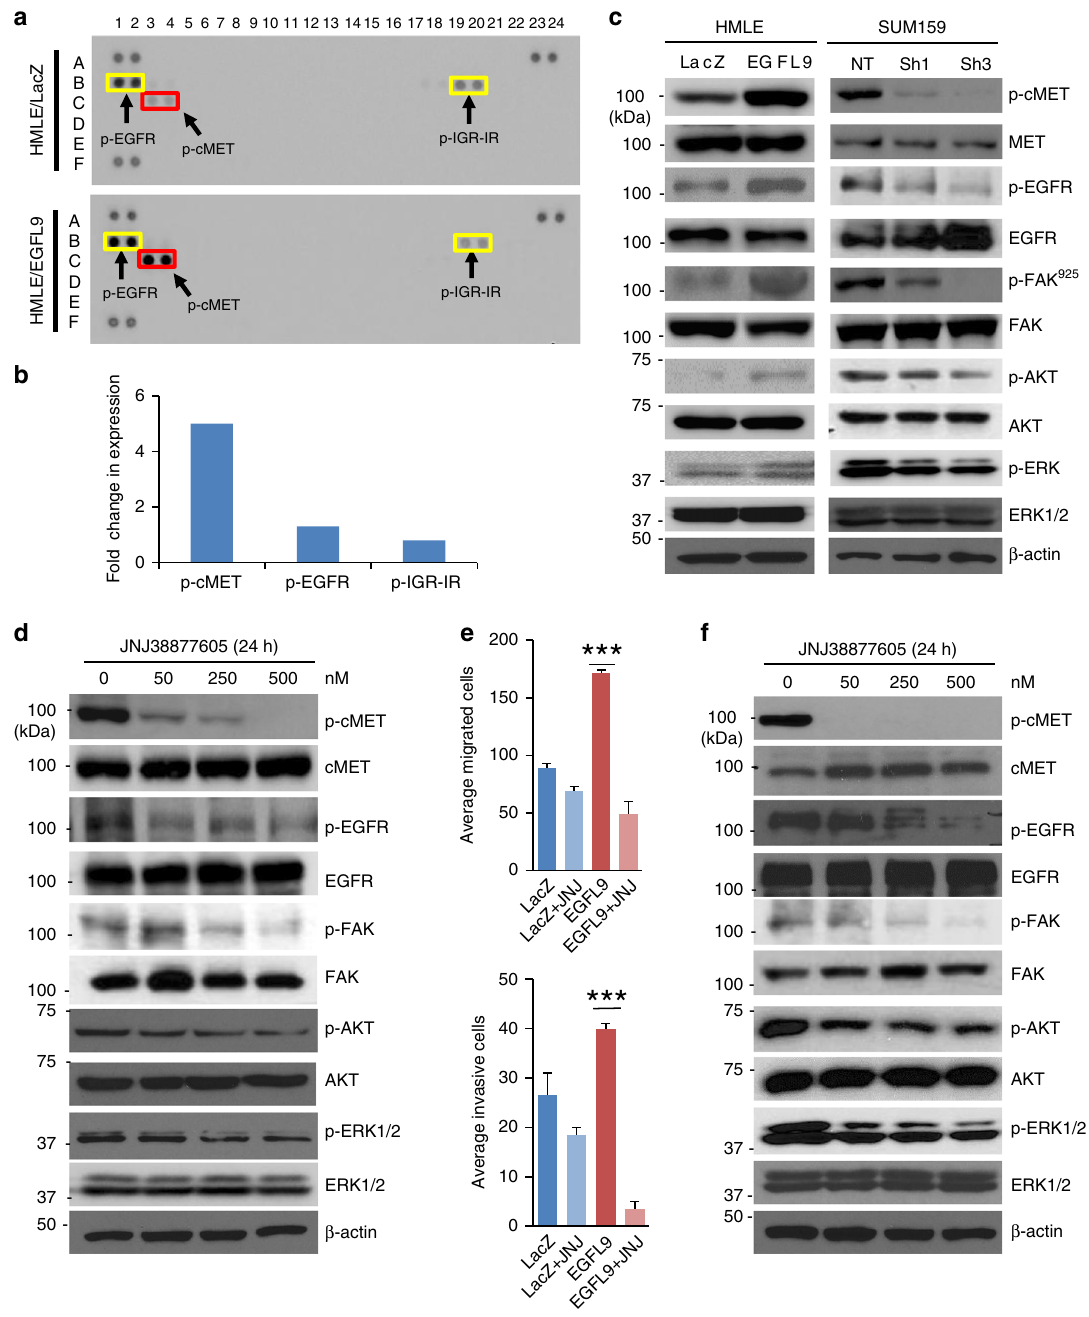
Fig. 5 EGFL9 speci fi cally activates cMET regulated signaling pathways. a Monitoring the receptor tyrosine kinase activation using a phospho-receptor tyrosine kinase array. Two isogenic cell lines, HMLE/LacZ and HMLE/EGFL9, were analyzed for signaling activation of a set of 49 receptor tyrosine kinases. b Quantitation of activation of cMET, EGFR, and IGR-IR in HMLE/EGFL9 cells in comparison with HMLE/LacZ. c Western blotting analysis of ectopic expression of EGFL9 in HMLE cells (left panel) and knockdown of EGFL9 in SUM159 cells. Phosphorylation and total cMET and cMET downstream targets (EGFR, FAK, AKT, and ERK) were examined. d Western blotting of cMET and its downstream targets in HMLE/EGFL9 cells after treatment with various concentrations of JNJ38877605 for 24 h. The antibodies used for the western blotting analysis were listed in the panels. e The treatment with JNJ38877605 leads to a signi fi cant decrease of cell migration (top panel, *** P < 0.001), invasion (bottom panel, *** P < 0.001) in HMLE/EGFL9, but not in HMLE/LacZ cells. Each bar represents the mean ± SEM (standard error of the mean). For three independent experiments, P value was determined by unpaired two-tailed t -test. f Western blotting of cMET and its downstream targets in SUM159 cells after treatment with various concentrations of JNJ38877605 for 24 h. The antibodies used for the western blotting analysis were listed in the